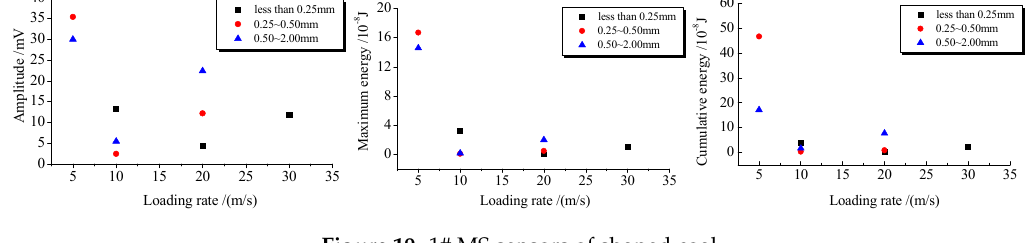
Figure 19. 1# MS sensors of shaped coal.